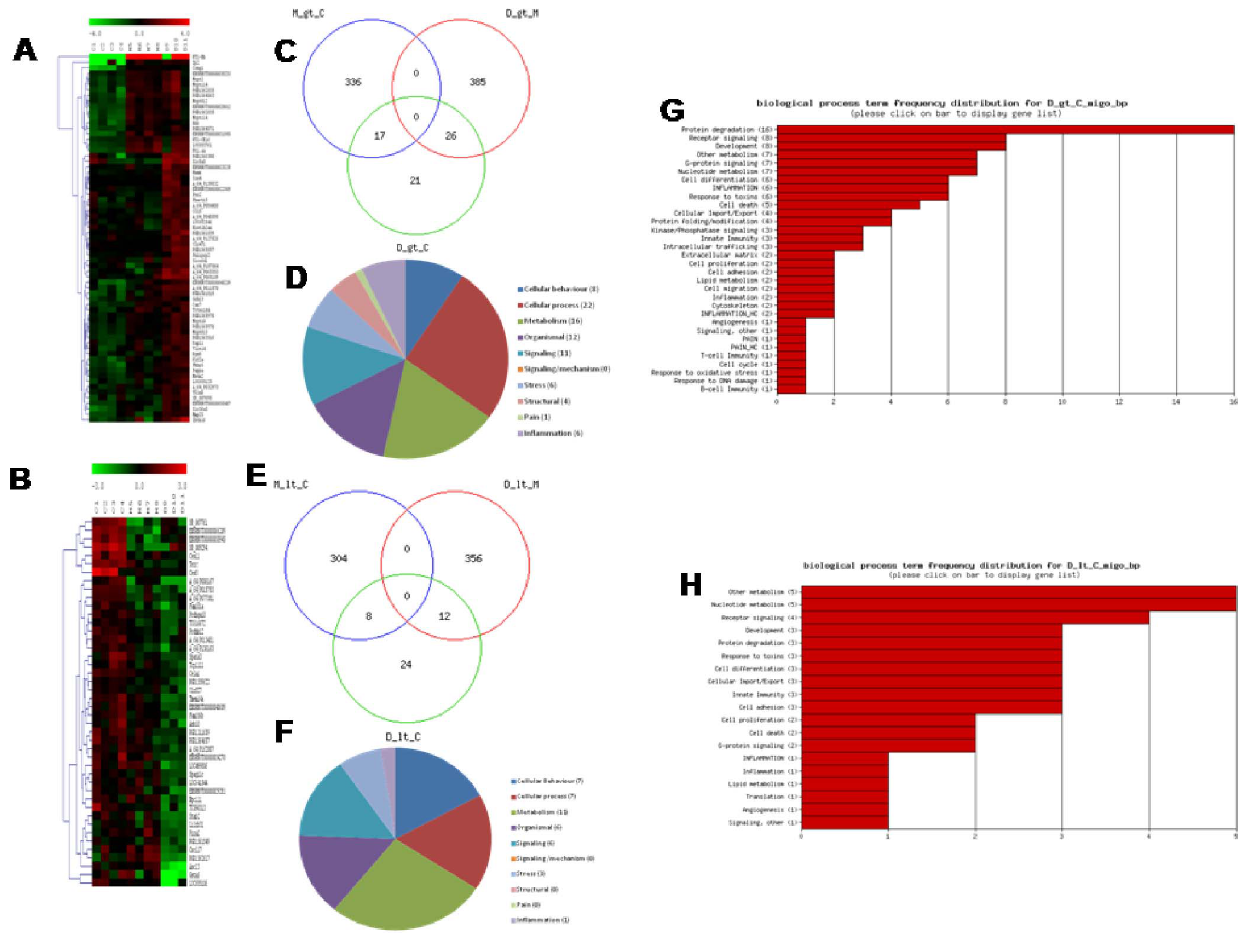
Figure 6. DGA and functional analysis of gene expression of VSL # 3-treated NMS rats in comparison with controls. (A–B) Heat maps analysis of changes caused by VSL # 3 administration (Group D, lanes D9–D11) to NMS rats on genes whose expression was modulated . 2-folds (up- or downregulation, p , 0.05) in comparison with control group (Group C, lanes C1–C4). NMS rats treated with VSL # 3 showed upregulation and downregulation of 64 and 44 genes respectively, indicating that the probiotic diet resets the colonic expression of genes to values observed in control rats. (C–E) Venn diagrams of regulated genes in Group D in comparison with Group C. In NMS rat, VSL # 3 administration induced an upregulation of 411 genes, 26 of which are also upregulated in Group C, and on a total of 368 downregulated genes in Group M, 12 were also dowregulated in Group C. The functional analysis in Group D vs Group C was illustrated by pie charts representing biological processes, molecular functions and cellular components among differentially expressed genes (D and F for up- and downregulated genes respectively). (G–H) Frequency distribution of the annotations for up- and downregulated genes respectively. Note that in VSL # 3-treated NMS rats only 1 gene belonging to the category ‘‘Pain’’ (the opiate receptor-like 1 gene) was upregulated and, in generally, a lower number of gene were significantly modified in group D in comparison with group C. gt: greater than; lt: lower than; migo_bp: gene ontology (GO) curated by Miltenyi Bioinformatics biological process/ function; Inflammation_HC: list of genes associated with inflammation from GO data but with more stringent selection criteria; Pain_HC: list of genes associated with pain from GO data but with more stringent selection criteria. Microarray data from 3–4 replicates.